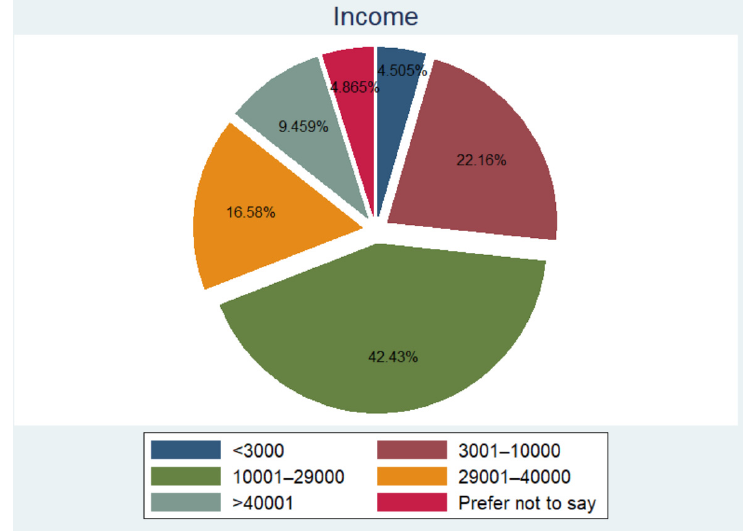
Figure 6. Income decomposition.